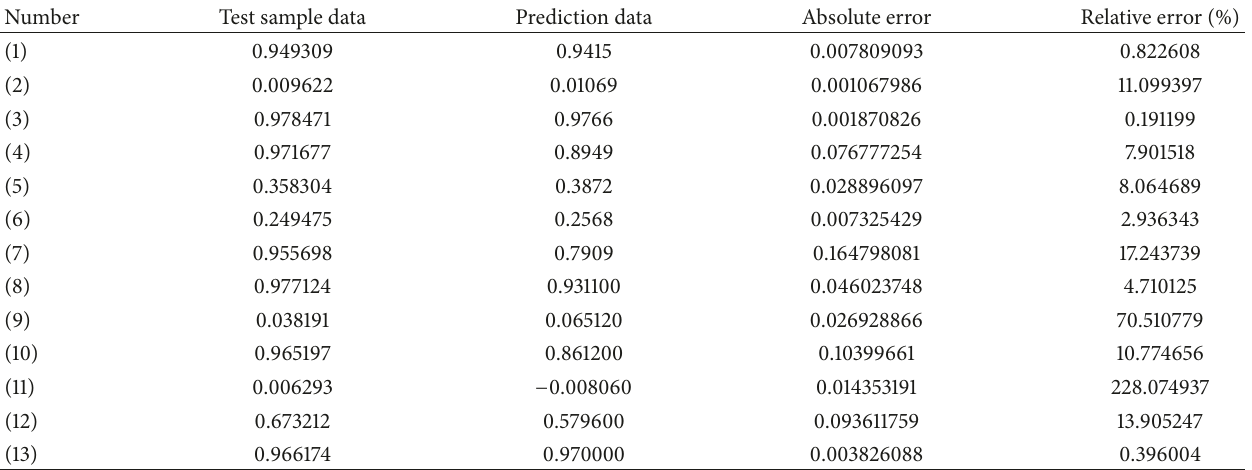
Table 7: Comparison of the neural network prediction output with the test sample data points.